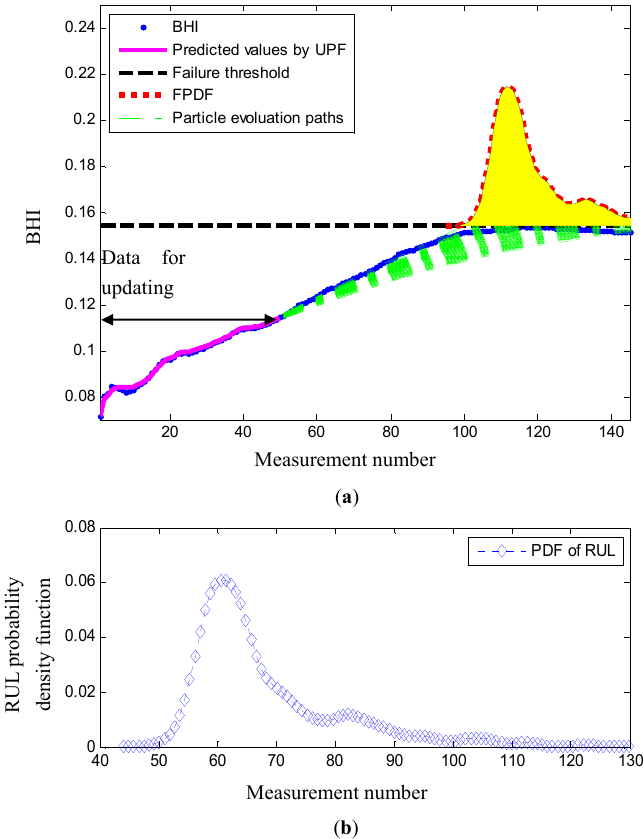
Figure 6. Bearing RUL prediction by using the proposed bearing prognostic method at measurement number 50. ( a ) The degradation trend; ( b ) the probability density function (PDF) of the RUL.